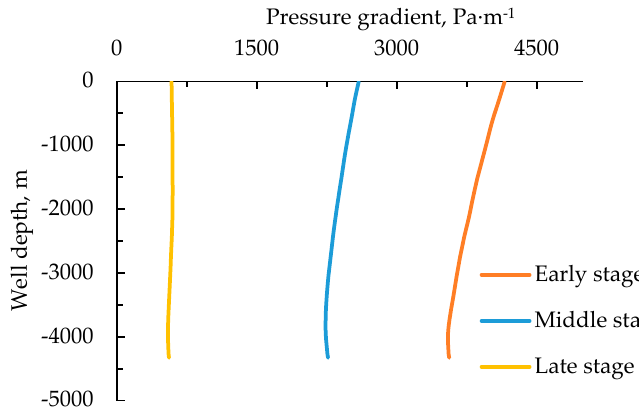
Figure 4. Pressure gradient changes along the wellbore at different stages. Table 7. The changes in physical properties, gas content and pressure gradient at different stages.